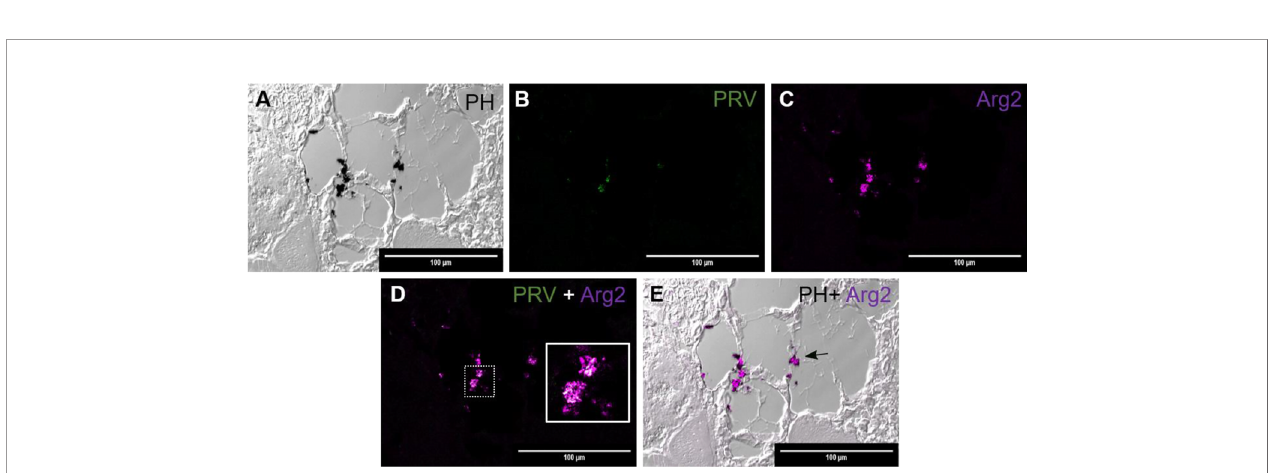
FIGURE 4 | Fluorescent in situ hybridization of PRV-1 and Arg2 in red focal changes (late phase). (A) Phase contrast image showing structure of the analyzed area and melanin deposit. (B) Sporadic presence of PRV-1 (green) in melanized area. (C) Arg2 (purple) positive cells (D) Merged image showing PRV-1 and Arg2 co- localization (white in the inset). (E) Merged image showing Arg2 positive staining of melano-macrophages (arrow). Scale bar = 100µm.